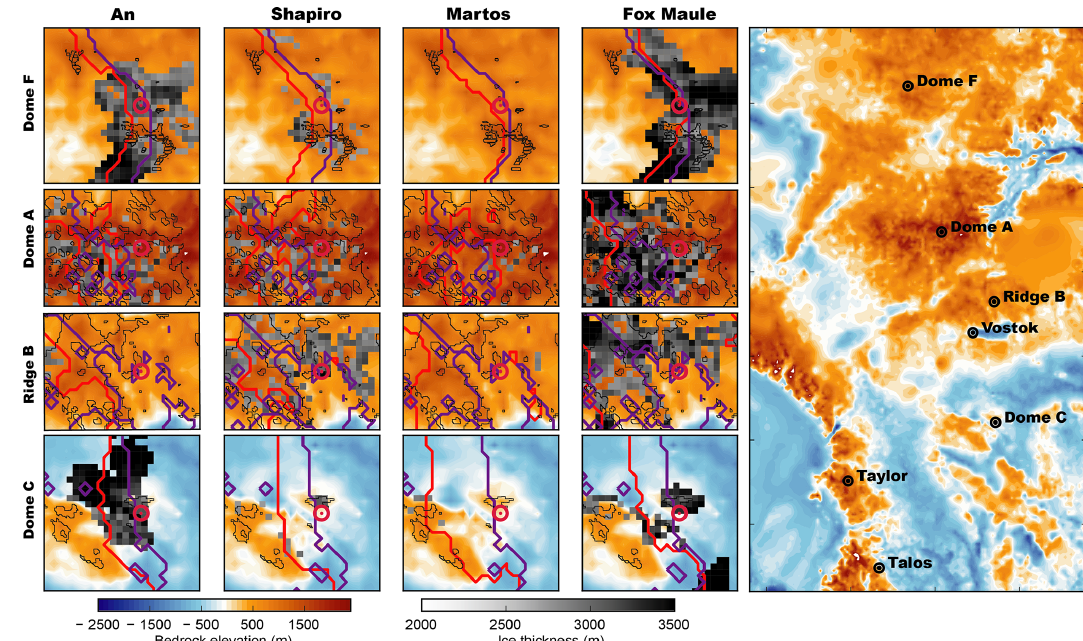
Figure 11. Comparison between regions of Oldest Ice identified in this study and in Van Liefferinge and Pattyn (2013) (Ridge B, Dome A) and Van Liefferinge et al. (2018) (Dome C, Dome Fuji) outlined by thick black lines. Regions of Oldest Ice are defined as grid nodes where ice thickness is larger than 2000m, basal melting is zero and surface ice velocity slower than 1ma − 1 (respective boxes coloured in greyscale). The left four columns show magnified sections centred at Dome Fuji, Dome A, Ridge B and Dome C for identical parameter sets and forcing but different geothermal heat flux. The respective GHF forcings used in the experiments depicted in the enlarged regions are from (left to right) An et al. (2015), Shapiro and Ritzwoller (2004), Martos et al. (2017) and Purucker (2013). The red line in enlarged regions depicts the simulated present-day ice divide (defined as position where surface elevation gradient switches direction), while the purple line depicts the present-day ice divide as computed from